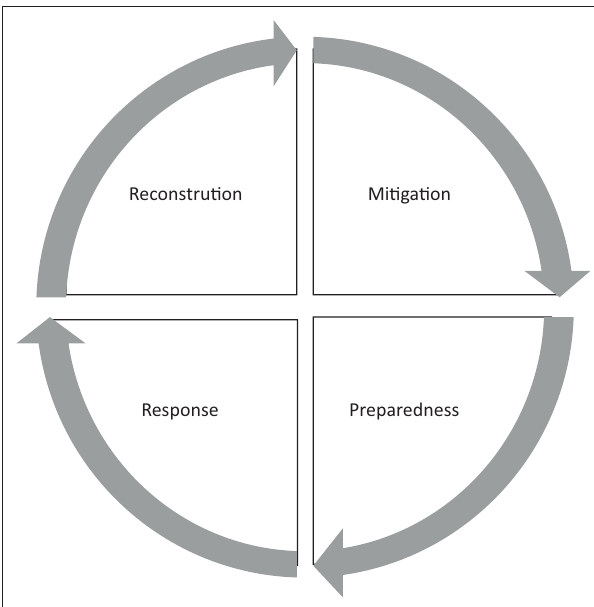
Reconstru(cid:22)on Mi(cid:22)ga(cid:22)on FIGURE 2: Stages in humanitarian logistics supply chain.